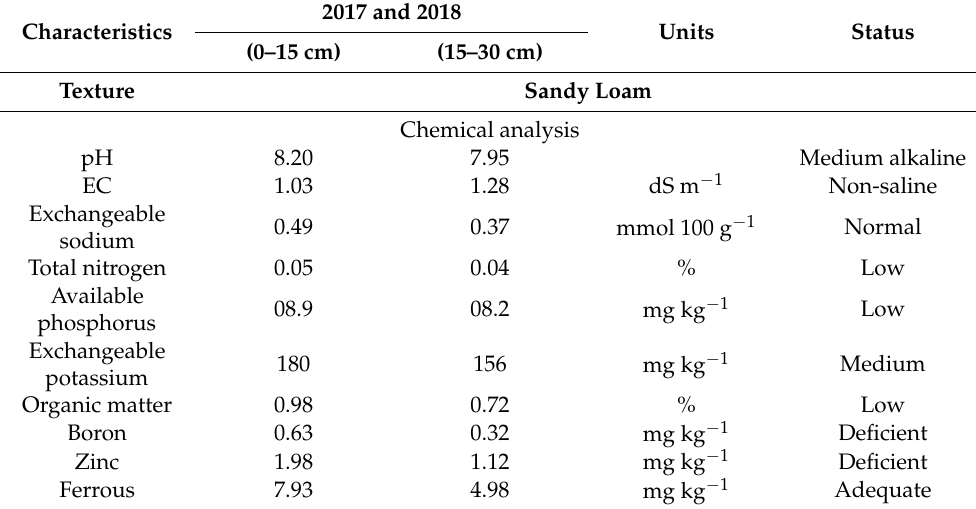
Table 4. Physico-chemical indices of the experimental soil for the years 2017 and 2018.